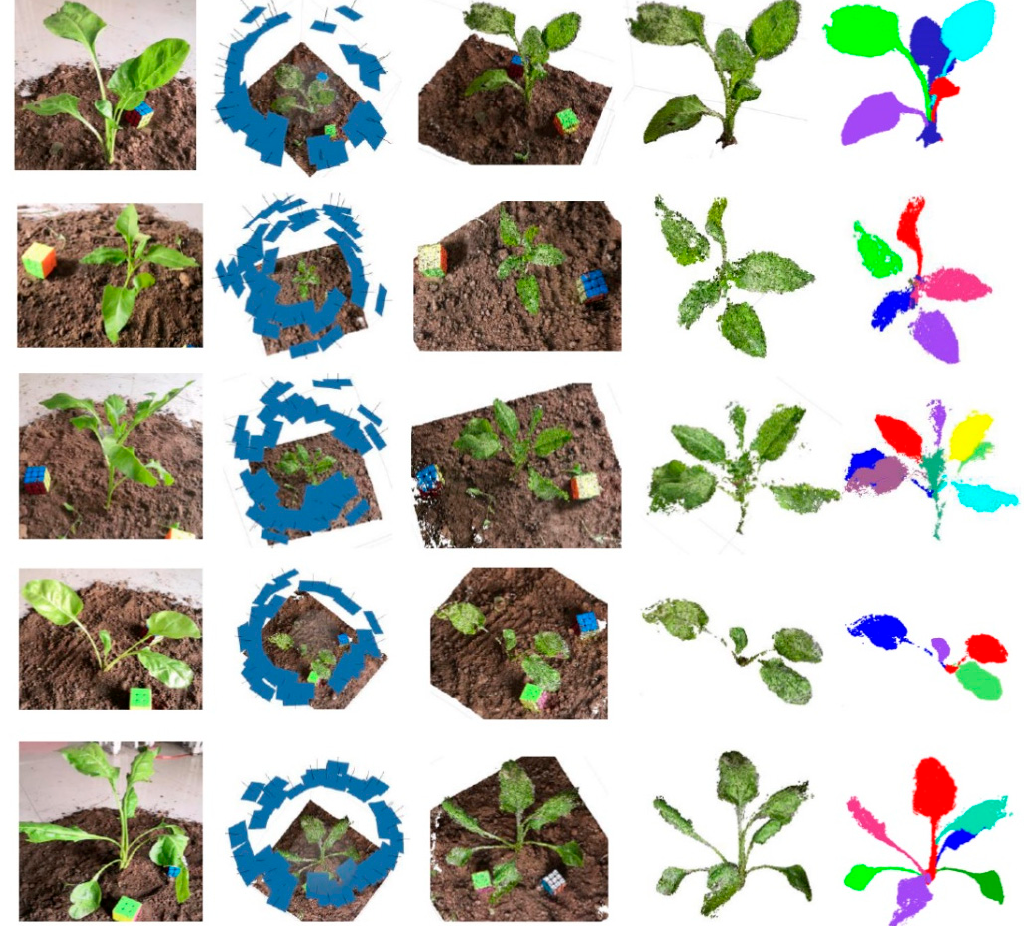
Figure 6. The results of the point cloud processing.